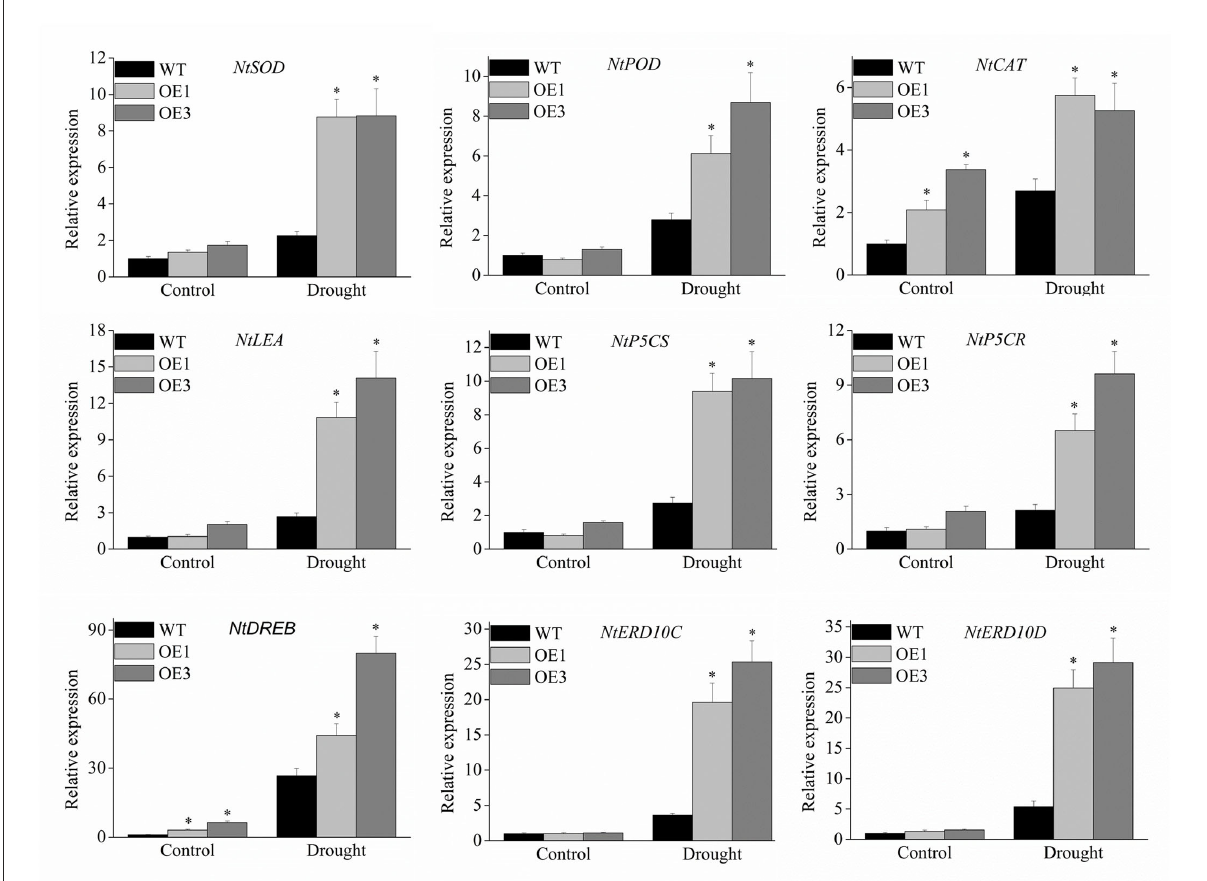
FIGURE9 Expression profiles of the stress-responsive genes in transgenic plants under drought stress. The expression data were normalized against the expression of NtActin . Bars represent mean ± SD. A significant difference from the WT was confirmed by a one-way ANOVA test, * p <